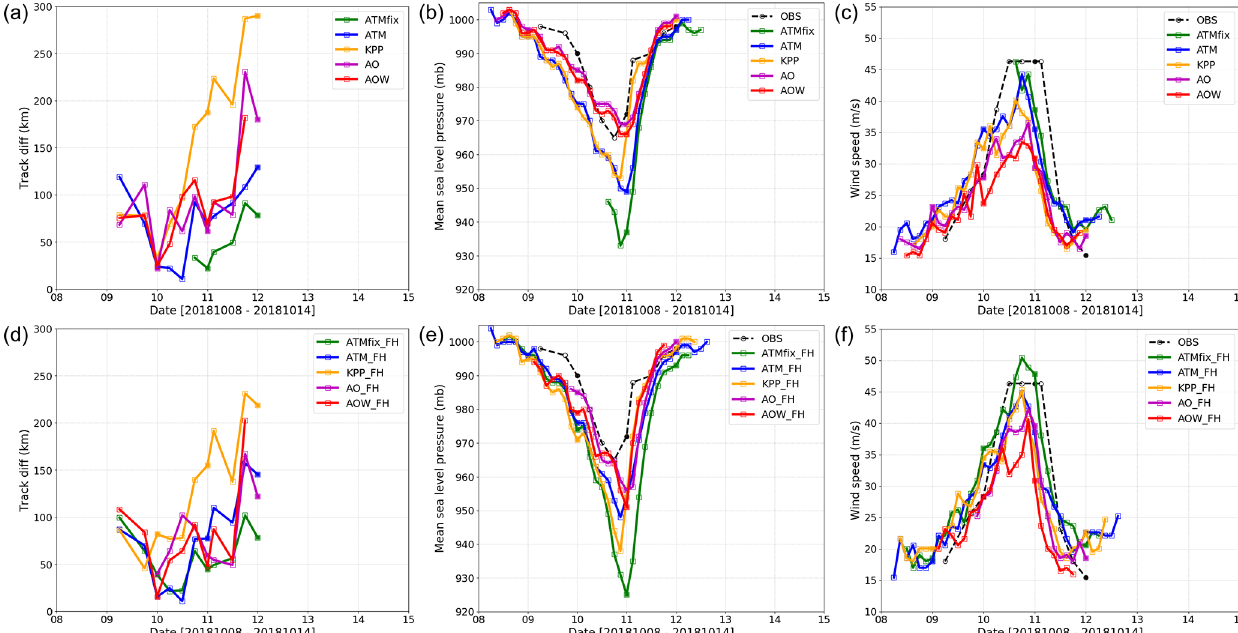
Figure 7. Comparison of observed and simulated cyclone track statistics for all simulations of cyclone Titli. Panels (a) – (c) show results without and (d) – (f) with frictional heating represented. Panels (a) and (d) show difference between coincident simulated and observed track position, (b) and (e) show mean sea level pressure at diagnosed track centre, and (c) and (f) show along-track maximum wind speed. Observed track data are taken from the SXXT50 bulletin based on satellite data interpretation.